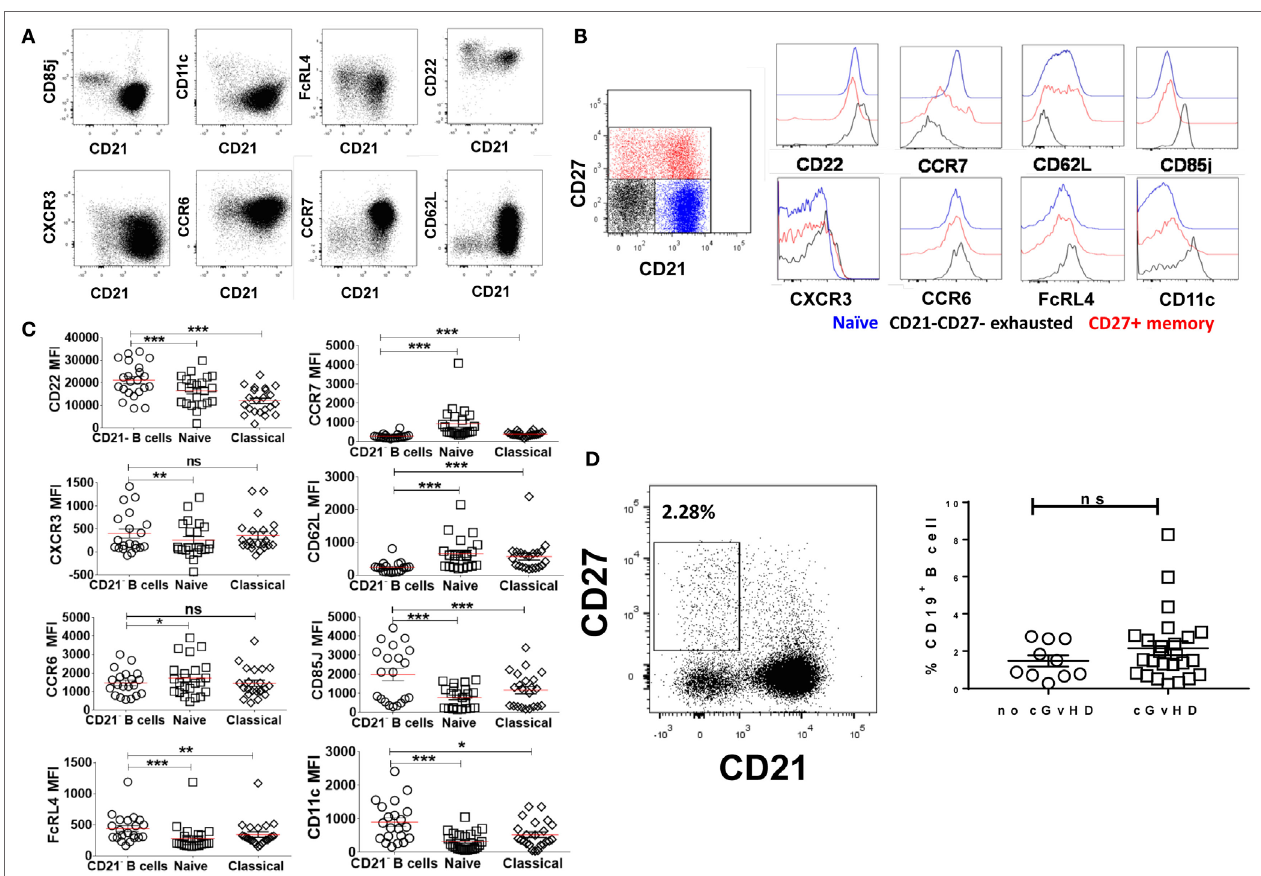
FigUre 3 | Expression of inhibitory and chemokine receptors on CD19 + CD21 − CD27 − CD10 − B cells. (a) FACS plots from a representative chronic graft-versus- host disease (cGvHD) patient show the expression of chemokine and inhibitory receptors on gated CD19 + B cells in relation to CD21. (B) Color-coded gating on CD27 + CD21 + in B cells from a representative cGvHD patient. The expression of inhibitory and chemokine receptors on naïve (blue), classical memory (red), and CD21 − B cells (black). (c) Inhibitory and homing receptor expression on CD21 − CD27 − CD10 − B cells relative to naïve and classical CD27 + memory B cells. Plots depict individual median fluorescence intensity (MFI) values for each cell subpopulation from 22 cGvHD patients. (D) FACS plot show gating strategy on CD21 − CD27 + activated memory B cells from a representative cGVHD patient (left). Scatter blot compare the frequency of activated memory B cells between the two post-transplant groups; p = ns. *Represents a p < 0.05, ** p < 0.01, and *** p <